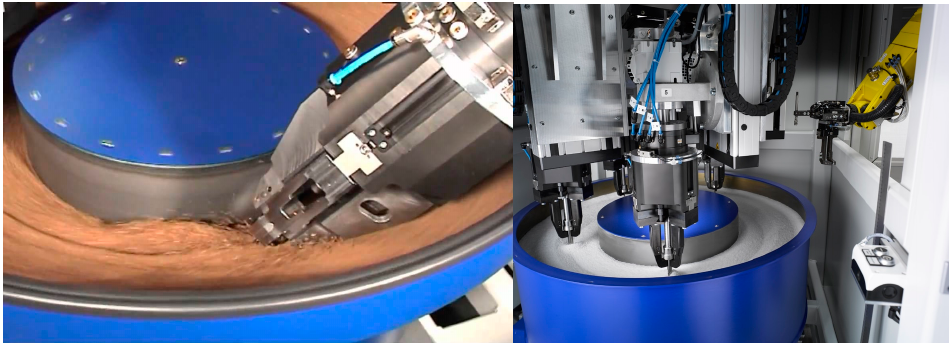
Figure 4. Stream finishing machine principle (LJMU).